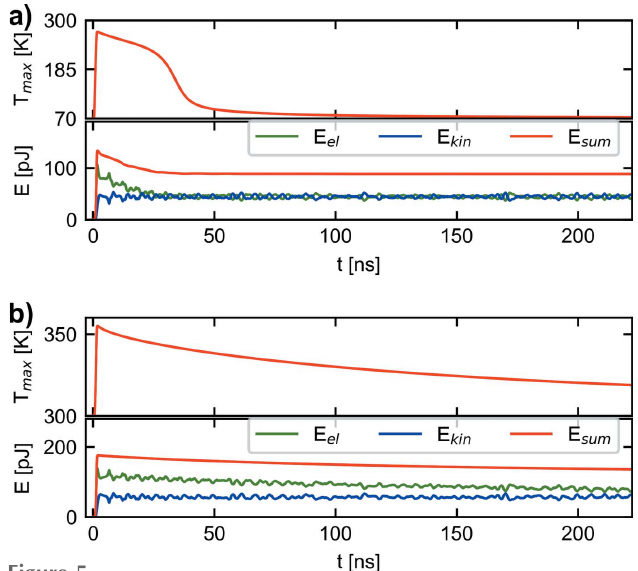
Figure 5 Temporal development of the maximum temperature value and the kinetic and elastic energy, calculated for an initial temperature of ( a ) T 0 = 70 K and ( b ) T 0 = 300 K.